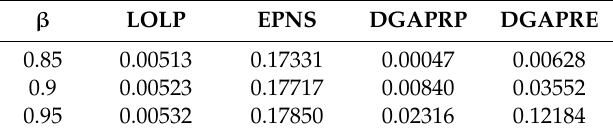
Table 4. Risk and DG active power reduction under different grid-connected inverter capacities.